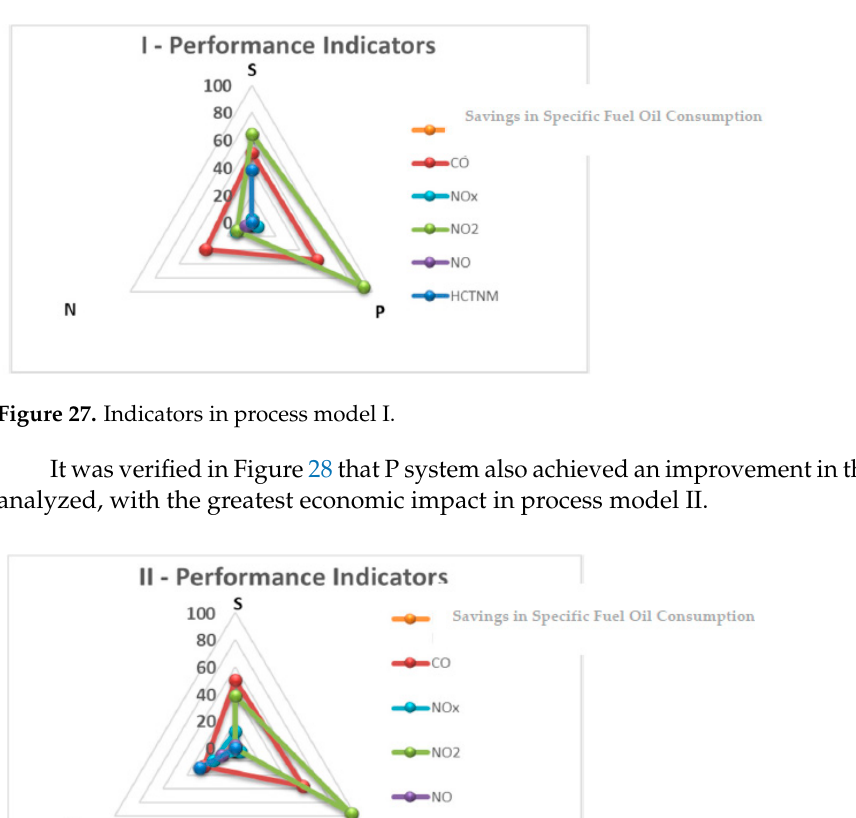
Figure 28. Indicators in process model II.